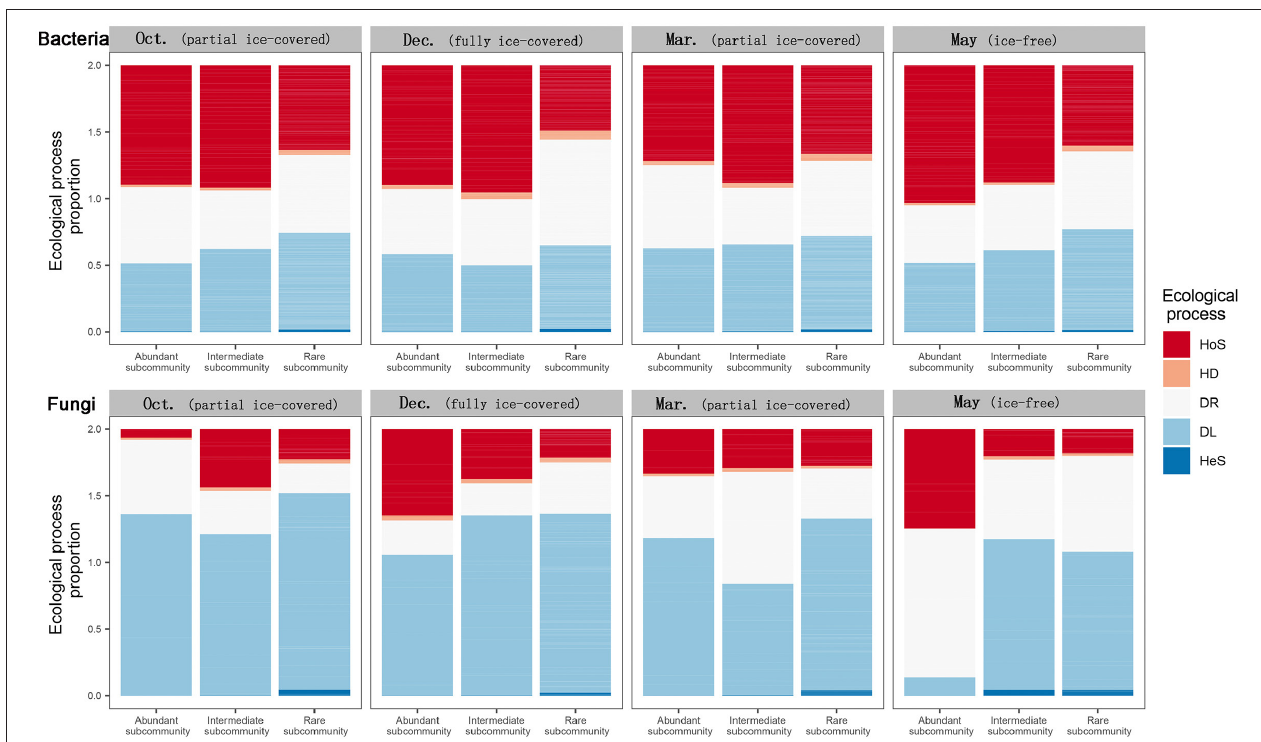
FIGURE 4 | Relative importance of different ecological processes to abundant, intermediate, and rare bacterial and fungal subcommunity assemblies during different ice-covered stages. Different fill colors indicate different community assembly processes: HoS, Homogeneous Selection; HD, Homogeneous Dispersal; DR, ecological drift (i.e., undominated processes, including drift, diversification, weak selection, and/or weak dispersal); DL, Dispersal Limitation; HeS, Heterogeneous